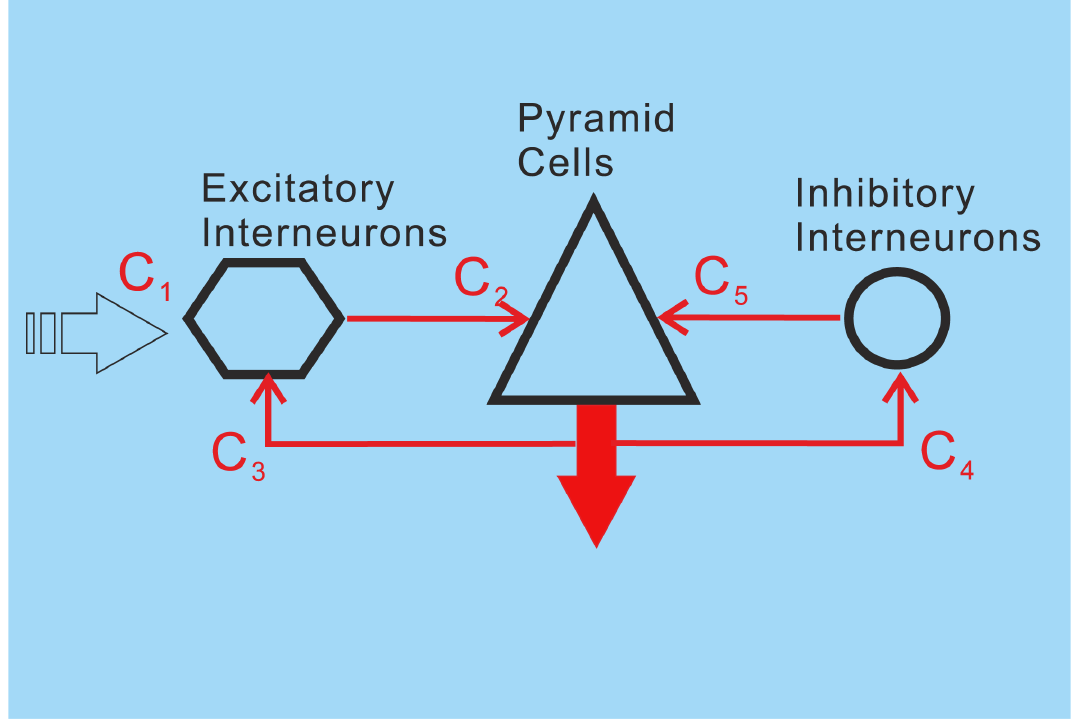
Figure 1. Neural mass model of Jansen and Rit with excitatory interneurons (EIN), pyramidal cells (PC) as well as inhibitory interneurons (IIN).